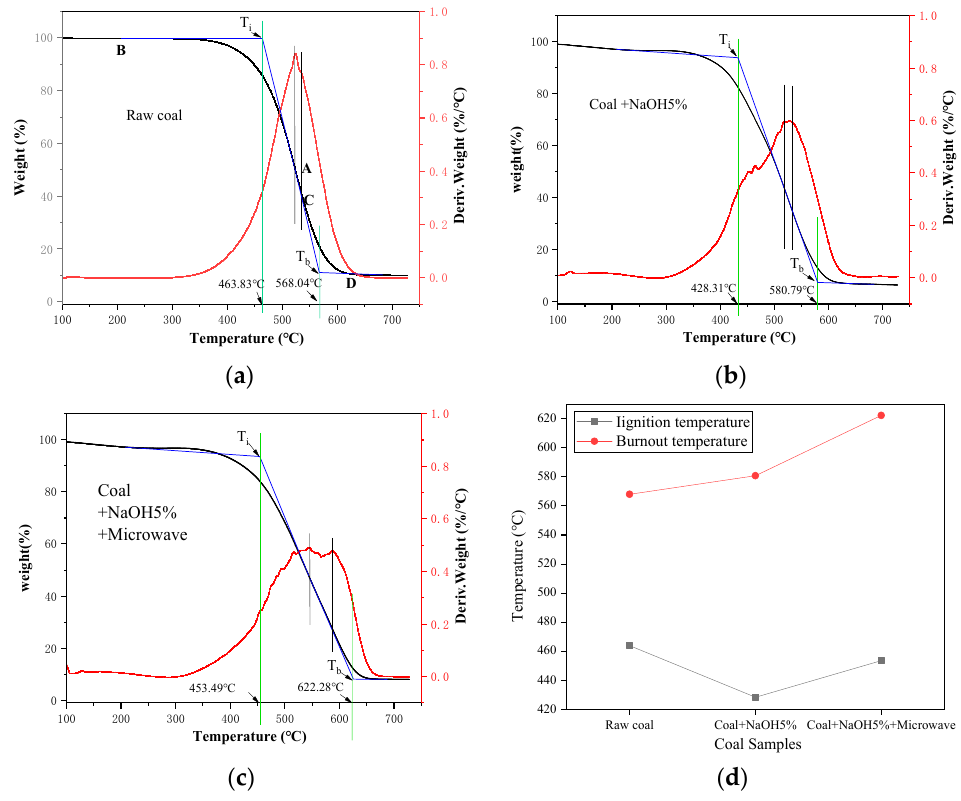
Figure 2. Thermos ‐ gravimetric and differential (TG ‐ DTG) curves of coal sample: ( a ) raw coal; ( b ) Coal treated with a 5% sodium hydroxide solution; ( c ) Coal treated with a 5% sodium hydroxide solution combined with microwave irradiation; ( d ) Ignition and burnout temperatures of samples. Table 3. S value of coal samples treated under different